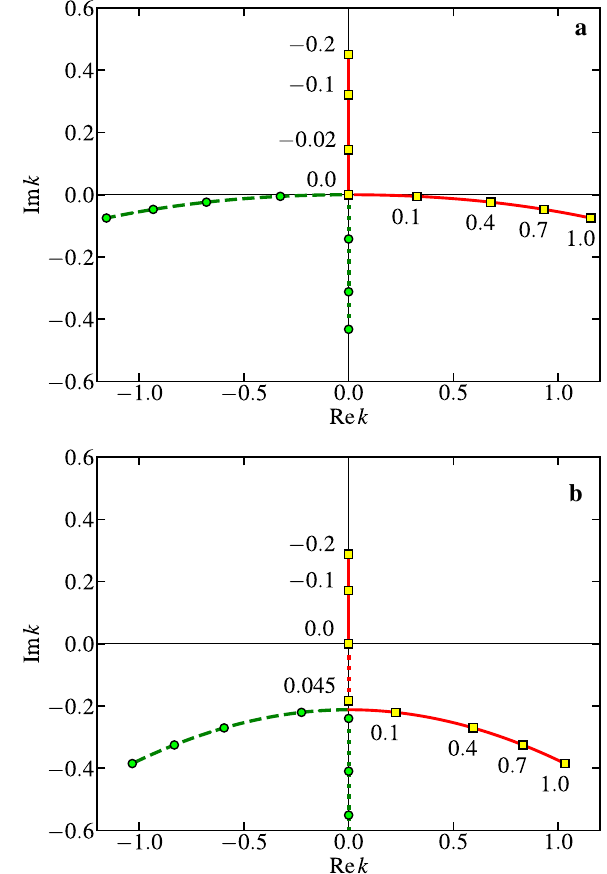
Fig. 2 The trajectories of the poles of the S -matrix in the complex k -plane near the boundaries of the lower (a) and upper (b) continua for (cid:2) = − 1 and R = 1 / 5. The solid line with Re k = 0 corresponds to a discrete level, the dotted line — to a virtual one. The solid line with Re k > 0 corresponds to the Breit–Wigner pole, the dashed line with Re k < 0 — to the second pole, located far from the physical domain. The tick marks indicate the values of respectively